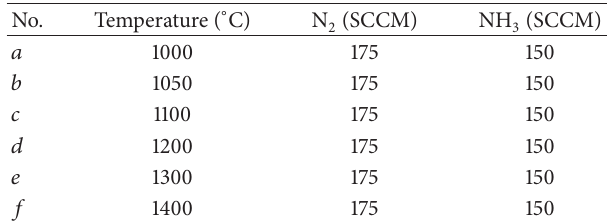
Table 1: Experimental operating